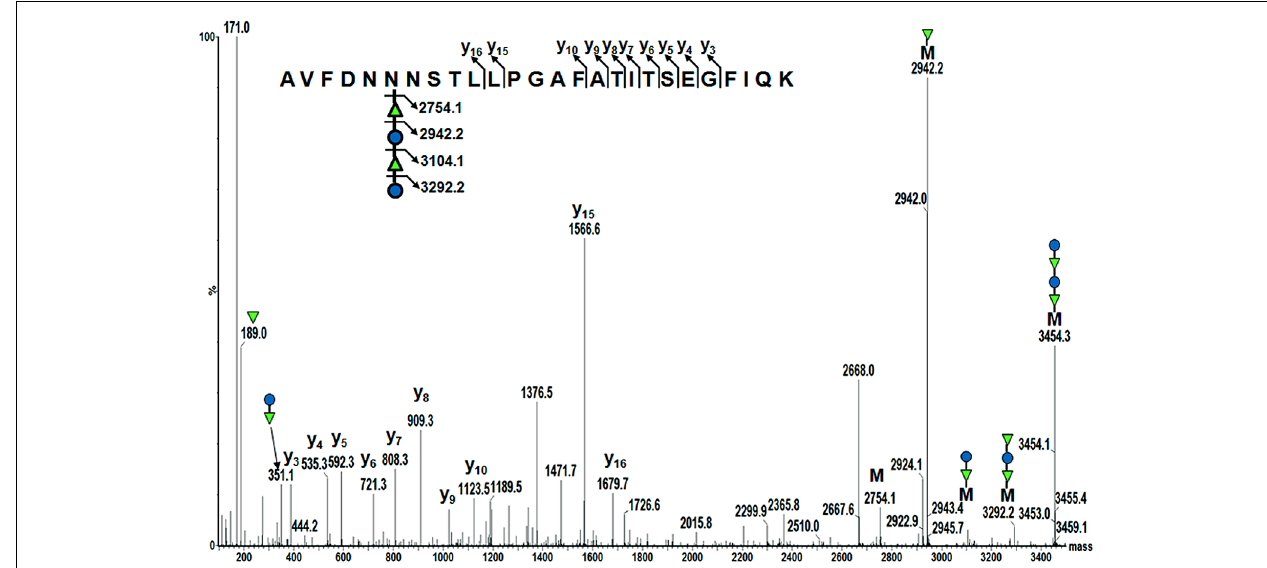
FIGURE 5 | Mass spectrometry identification of the B. pseudomallei OPS II glycan attached to AcrA. MS analysis of tryptically digested glycosylated AcrA revealed a peak of m/z 1152.06 3 + . MS/MS of this peak showed a previously characterized glycosylation site of AcrA (AVFDNNNSTLLPGAFATITSEGFIQK; 2754.1 Da) with a modification of